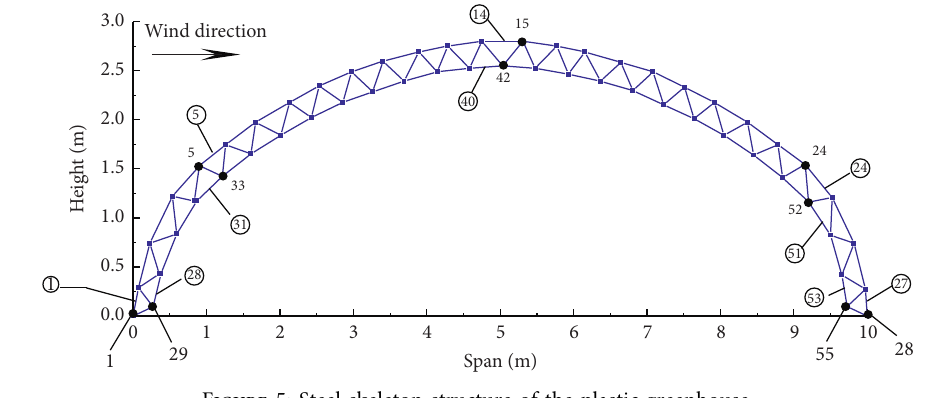
Figure 5: Steel skeleton structure of the plastic greenhouse.